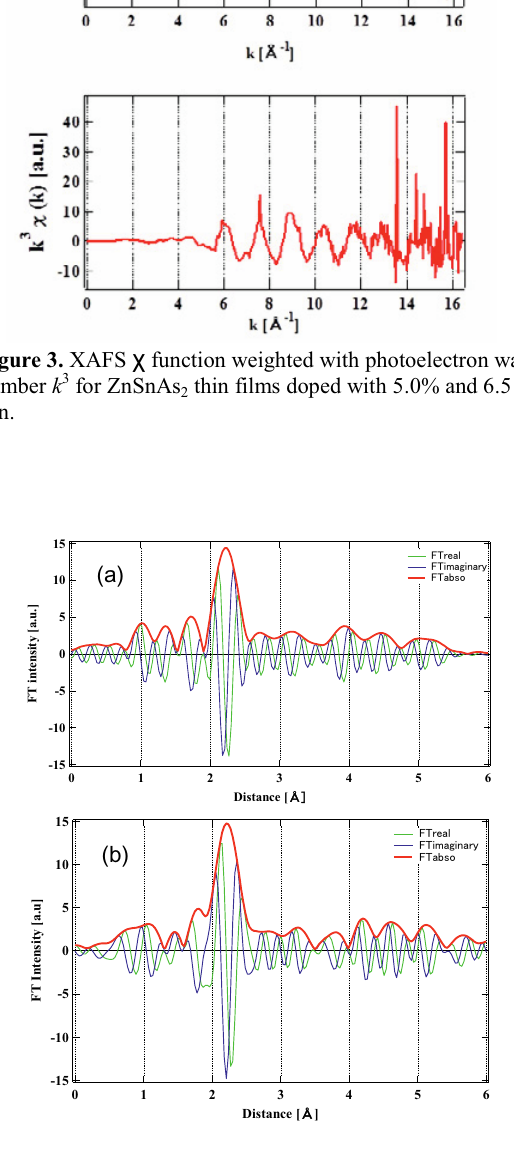
Figure 4. Fourier transform (radial distribution function) around the Mn atom in Mn-doped ZnSnAs 2 with Mn concentrations of (a) 5.0% and (b) 6.5%.